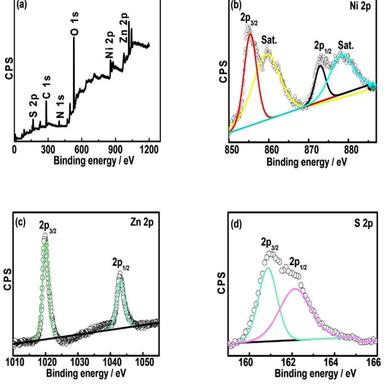
XPS analysis of ZnS/Ni3S2: (a) full spectrum; (b), (c) and (d) are respectively the Ni2p, Zn2p and S2p high resolution spectra. "Sat" in Fig. 2b denotes satellite peaks.